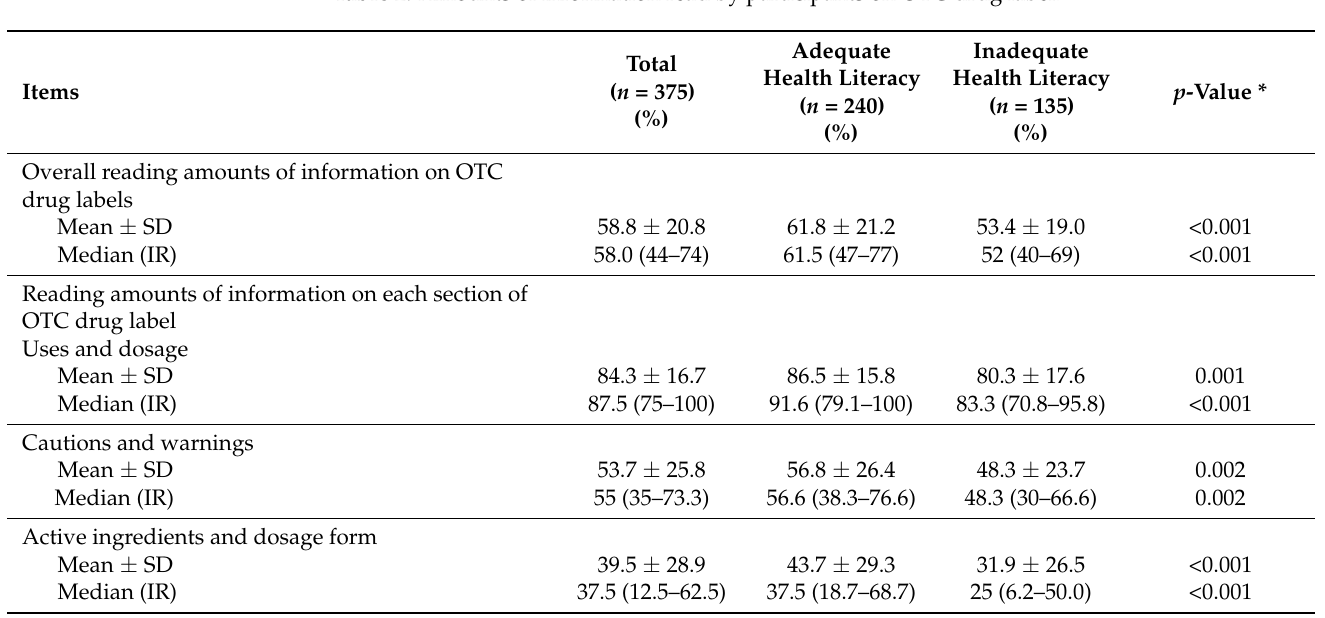
Table 2. Amounts of information read by participants on OTC drug label.